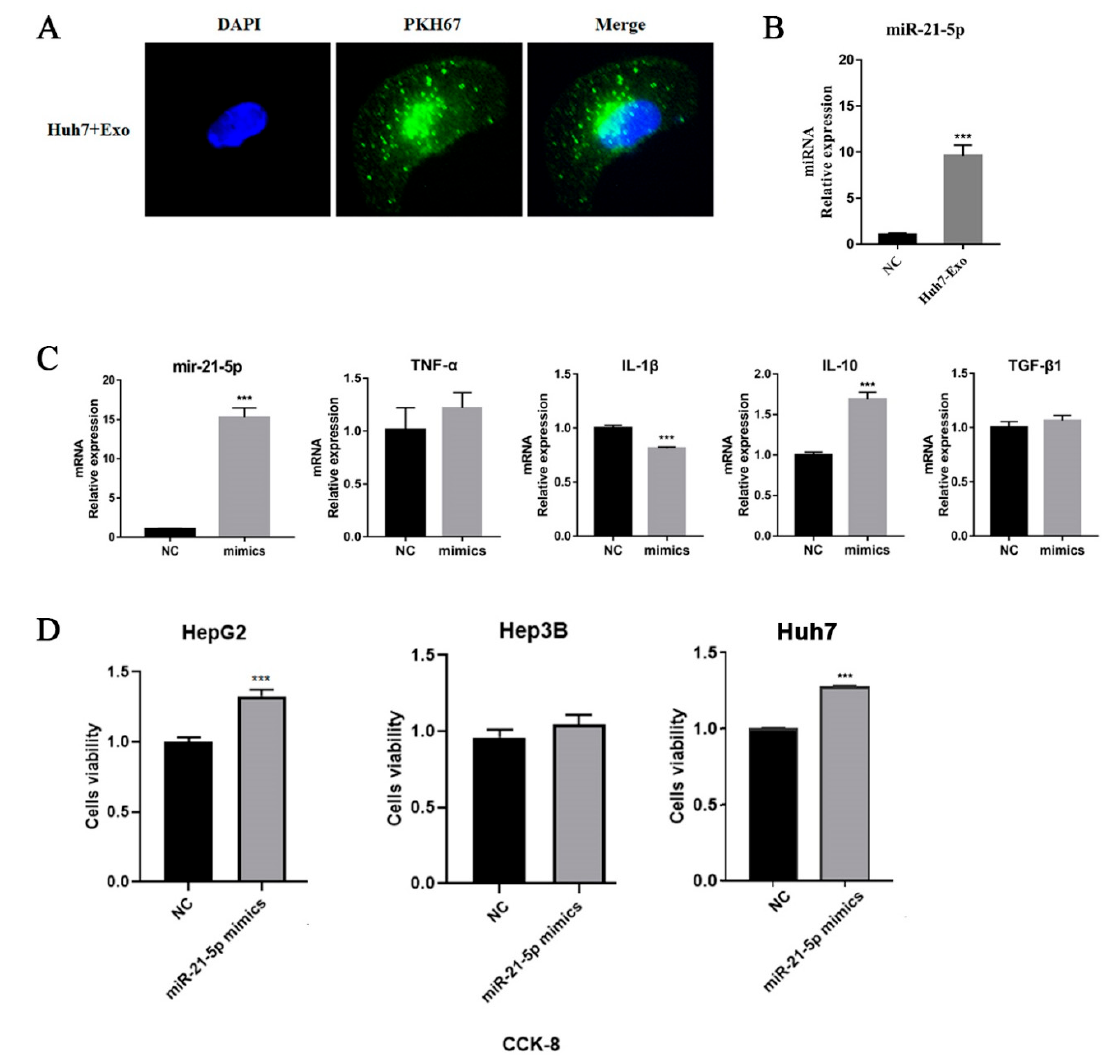
Figure 4. Tumor-derived exosomes regulate macrophage M2 polarization. ( A ) HCC cell line-derived exosomes were labeled by PKH67 and co-cultured with THP-1 cells for 24 h. The results were observed by fluorescence microscopy. ( B ) miR-21-5p level was detected by qPCR. ( C ) Transcriptional level of cytokines of THP-1 cells after mir-21-5p mimics transfection. 1 × 10 5 THP-1 cells were seeded in 6-well plates and were treated with PMA for 48 h. miR-21-5p mimics were transfected into THP-1 cells using lipofectamine 2000. RNA was extracted from cells to perform qPCR detection. ( D ) The supernatant of THP-1 was used to treat HCC tumor cells (HepG2, Hep3B, and Huh7) for 48 h; cell viability was detected using CKK-8 assay. *** p < 0.001.